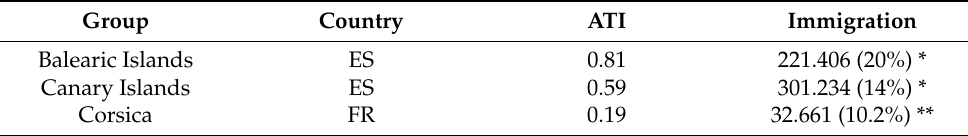
Table 6. ATI and immigration rate in Corsica, Balearic, and Canary Islands. Group Country ATI Immigration Balearic Islands ES 0.81